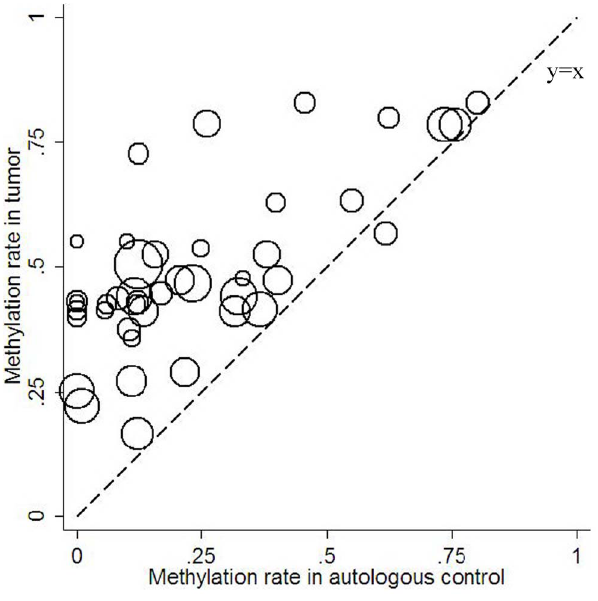
Figure 4. Methylation frequency in tumor tissue versus autologous